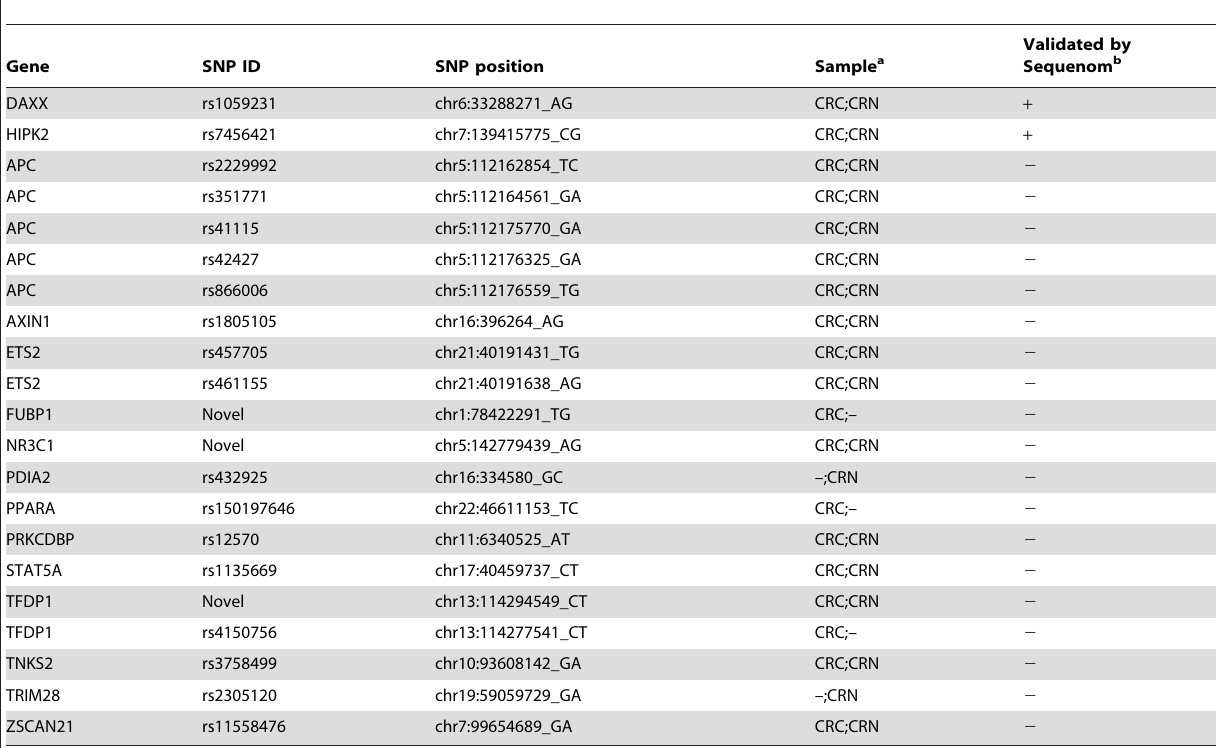
Table 3. List of synonymous SNPs with ESE/ESS motifs